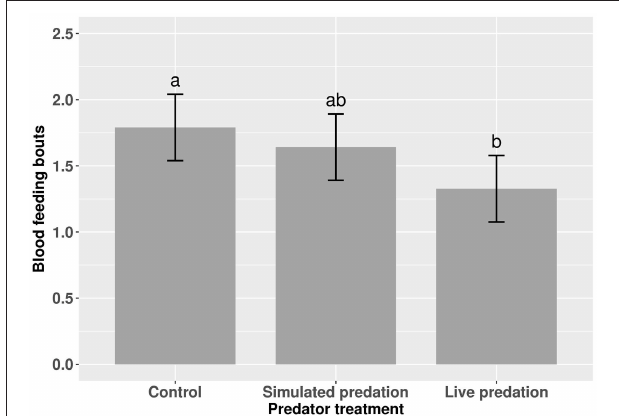
FIGURE 5 | Number of blood feeding bouts required for adult female Aedes aegypti to successfully take a blood meal. Values plotted are least squares means ± 95% CI. Data were statistically tested using ANOVA and significant effects are described in Table 5 . Treatment means associated with the same letters are not significantly different in pairwise comparisons using Bonferroni adjustment for multiple tests.